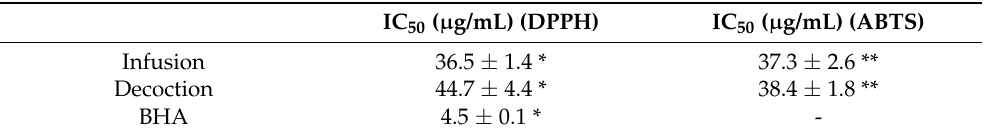
Table 3. Antioxidant activity of aqueous extracts of Crithmum maritimum L. and BHA by DPPH and ABTS methods. The results are expressed as mean ± SD of three independent experiments (n = 3) performed in duplicate. The statistical analysis was performed with p <